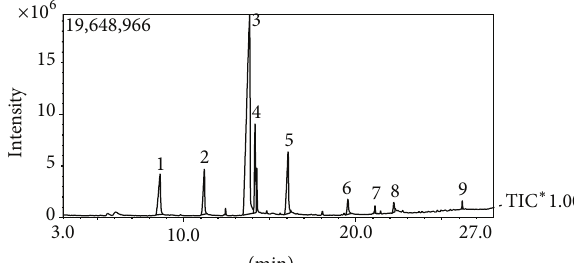
Figure 2: GC/MS analysis showing peaks of detected metabolites in ethanolic extract of Lenzites